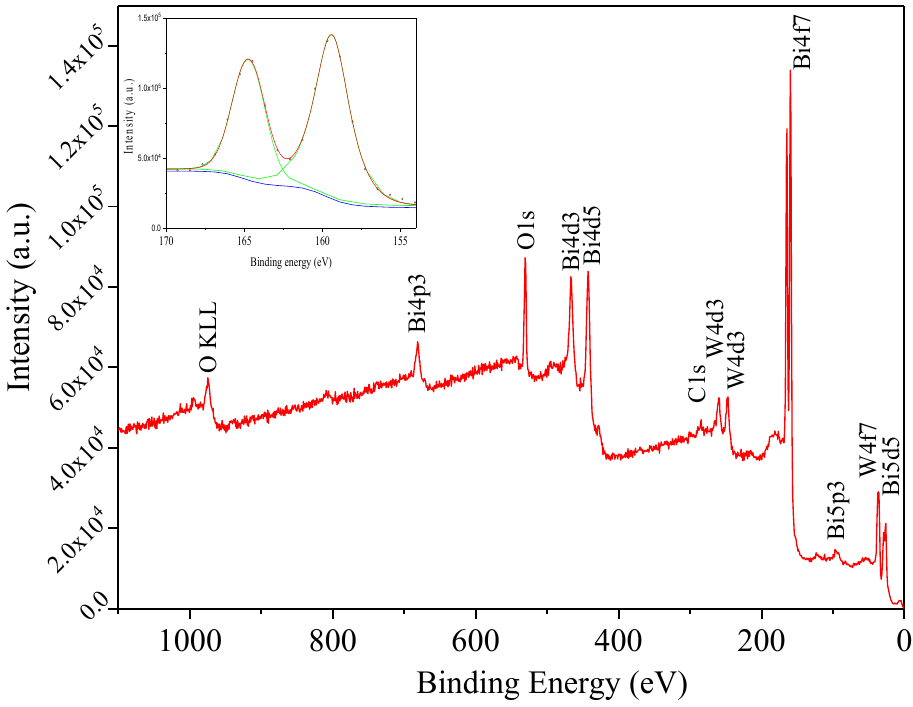
Figure 3. XPS survey spectra of the hydrothermally prepared Bi 2 WO 6 sample at 200 °C for 24 h. Inset